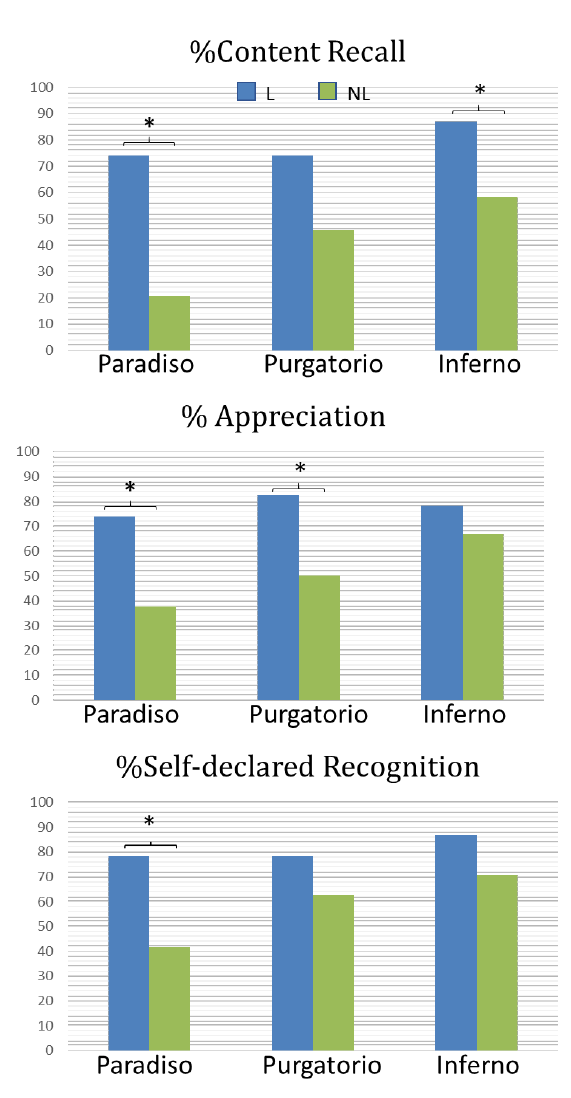
Figure 3. Graph representing the significant differences between the GROUPS (L: Literature students; NL: Non-Literature students) resulting from the Fisher’s exact test performed on behavioral data. Asterisks denote a statistical significance equal or lower than * p = 0.05.